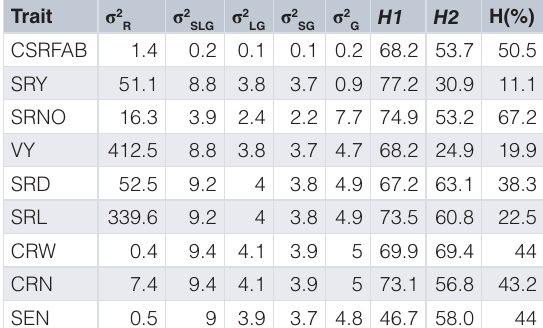
Table 5. Variance components, within and across environment heritability estimation for nine characters associated with continuous storage root formation and bulking in sweetpotato.